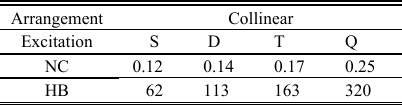
TABLE II. Run time (sec) of HB and NC techniques for infinite parallel array of nonlinear antennas.